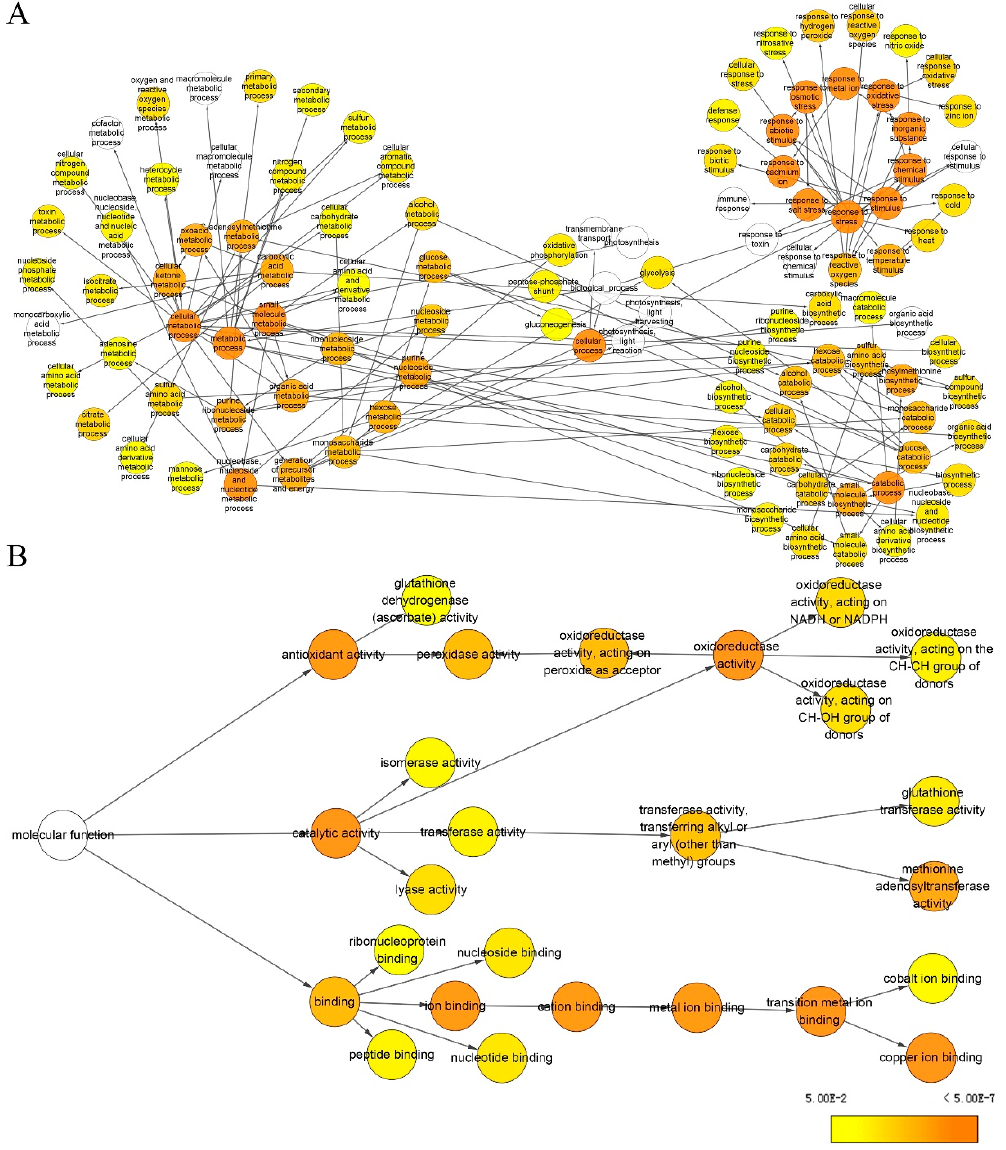
Figure 8. Biological pathway ( A ) and molecular function ( B ) networks generated by BiNGO. Homologous proteins were used for the gene ontology (GO) analysis. The size of the node is related to the number of proteins and the color represents the p -value for statistical significance of the overrepresented GO term (see the color scale on the right bottom).